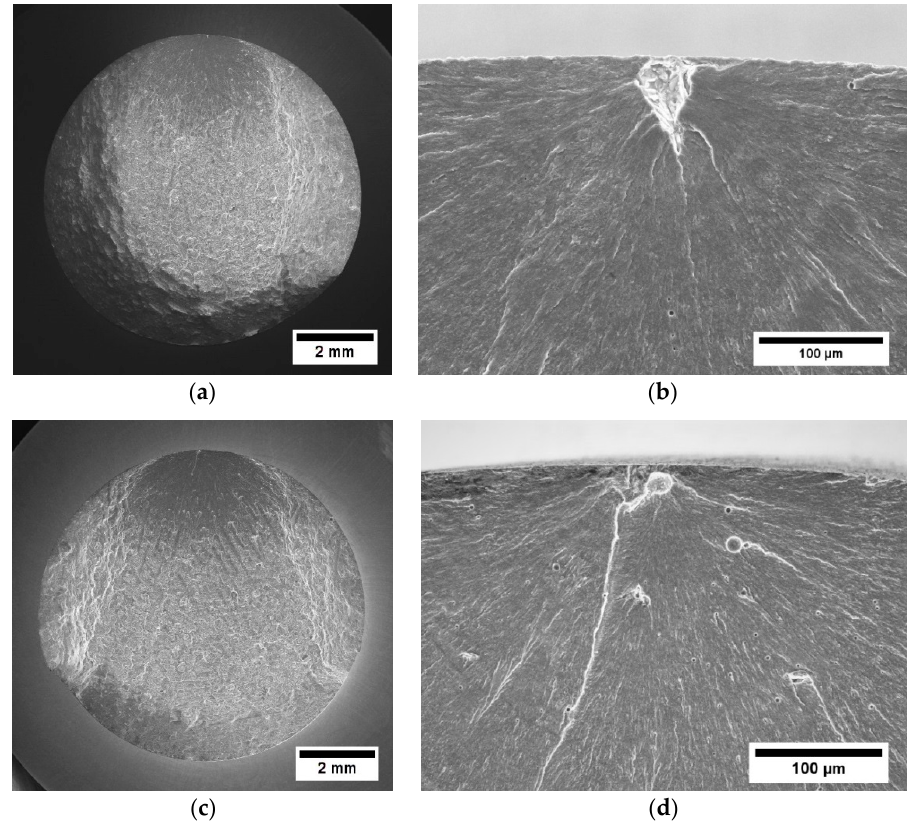
( d ) Figure 14. Fracture surfaces of SB samples failed at maximum stress level of 175 MPa; ( a , b ) the specimen failed by crack nucleation from a subsurface defect; ( c , d ) the specimen failed by crack